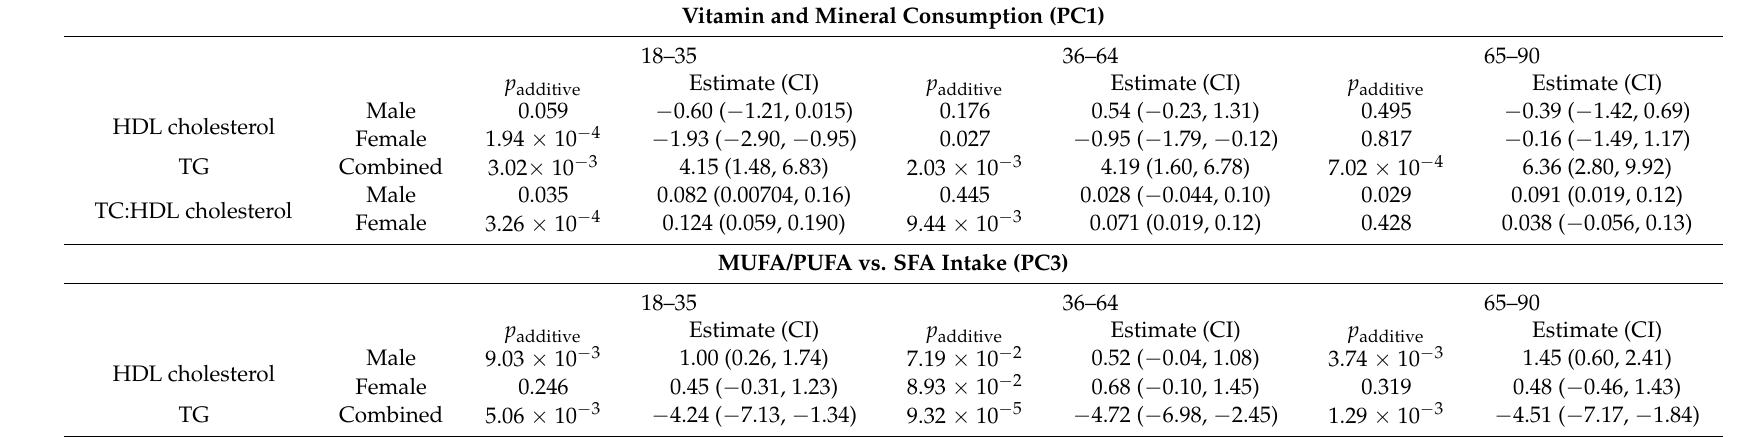
Table 2. Significant lipid by nutrient correlations stratified by age and